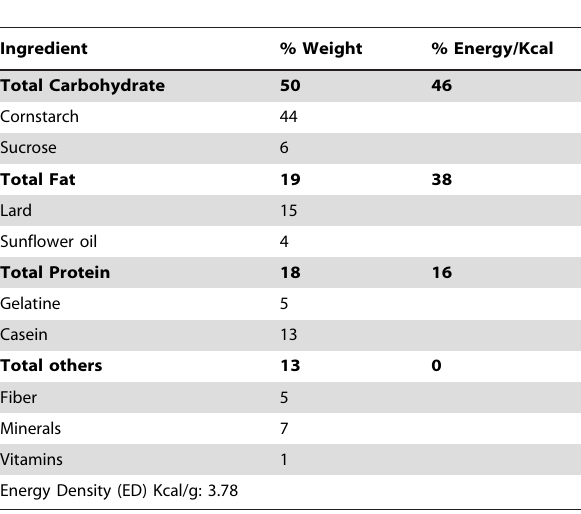
Table 6. High-fat diet composition – Australian